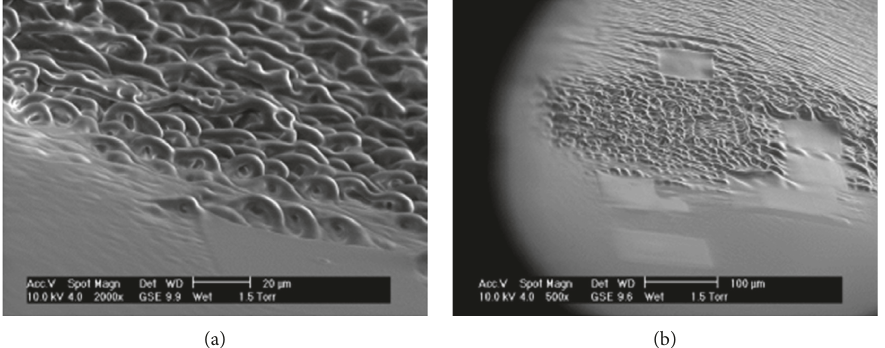
Figure 14: (a) Micrograph of an asphalt sample after 2minutes irradiation. (b) Electron effects in that asphalt due to double irradiation. The figure is obtained from Gaskin [44] (under the creative commons attribution license/public domain).